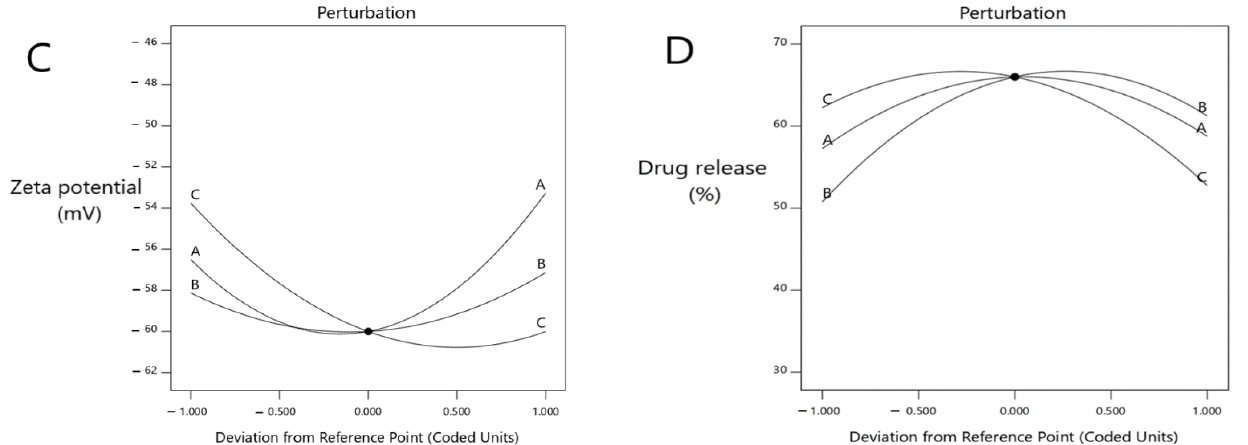
Figure 2. Perturbation explains the influence of the independent variables at ( A ) the EE%, ( B ) vesicles size, ( C ) ZP (mV) and ( D ) percent of drug release after 8 h.